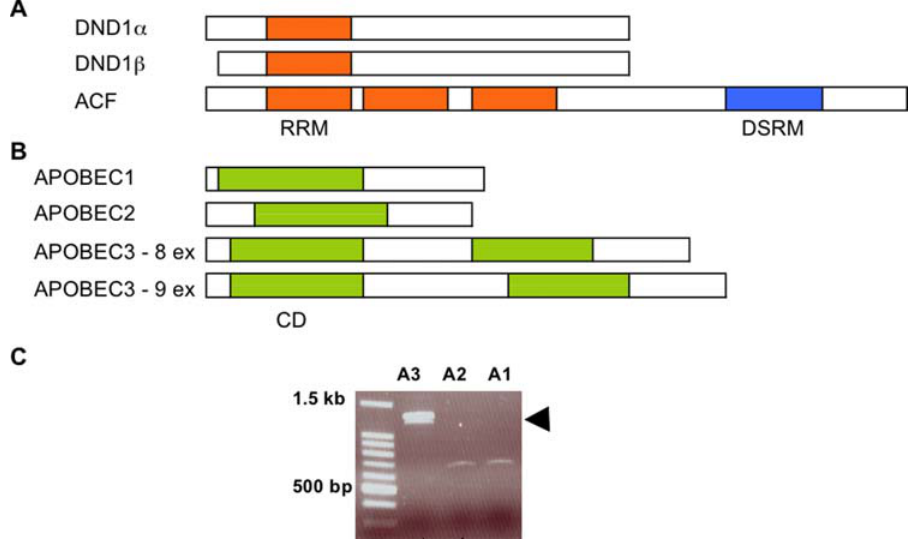
Figure 1. (a) Comparing DND1 and ACF. Representation of DND1 a , DND1 b and ACF proteins, drawn to scale. RNA recognition motif (RRM) is indicated in orange. ACF possesses 2 additional RRMs not found in DND1 as well as a double-stranded RNA binding motif (DSRM). The protein structure analyses are from NCBI conserved domain database (CDD). (b) Comparing APOBEC proteins. The protein coding regions of APOBEC1, APOBEC2, APOBEC3 (8 exon isoform) and APOBEC3 (9 exon isoform) are compared. The cytidine deaminase (CD) domains are indicated in green. APOBEC3 possesses 2 cytidine deaminase domains, which are not functionally equivalent. The protein structure analyses are from NCBI conserved domain database (CDD). (c) RT-PCR amplifies Apobec1 , Apobec2 and Apobec3 from mRNA of 129 mouse testes . Transcripts of both isoforms of Apobec 3 (with 8 and 9 exons, respectively) are indicated by the doublet band (arrow).